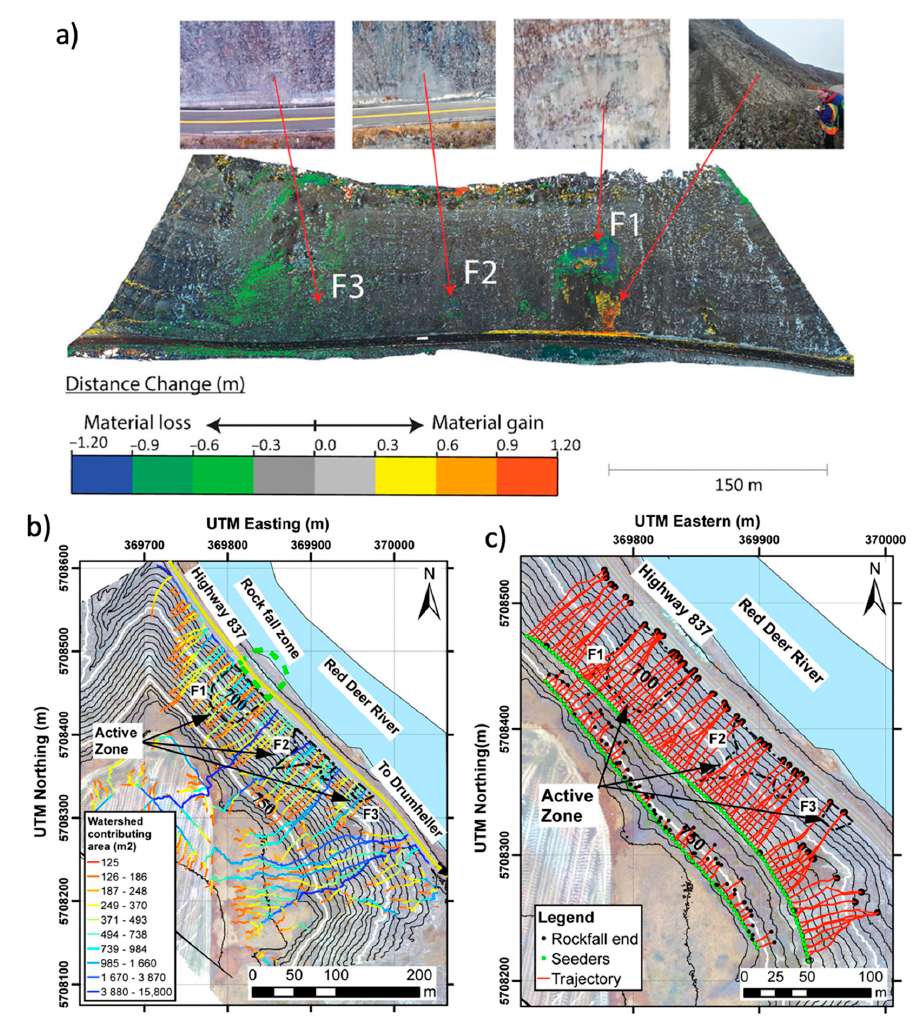
Figure 5. Change Detection between December 2017 and November 2018 ( a ), surface drainage model on the November 2018 surface model ( b ), and plan view of rock fall trajectories on November 2018 surface model ( c ). After [35].